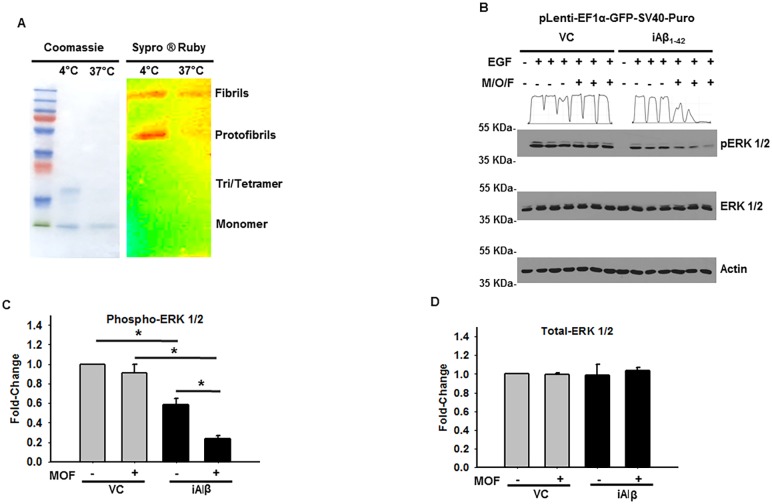
Differential influence of eAβ and iAβ on MAPK activity.(A) Confirmation of successful generation of extracellular monomeric, oligomer and fibrillar quaternary organization. Coomassie brilliant blue stained, 15% SDS PAGE gel, showing the varying eAβ quaternary organization states at 4°C and 37°C oligomerization protocols. Preferential staining of lower order eAβ organization observed using coomassie staining at 4°C. Sypro ® Ruby stained, 15% SDS PAGE gel, of eAβ1–42 revealing the higher order quaternary organization states. (B) Immunoblot of the phospho-ERK 1/2 and total-ERK 1/2 in VC or iAβ transduced HEK293 cells following 24 h pretreatment with monomeric/oligomeric/fibrillary (M/O/F) eAβ and subsequent EGF stimulation. No differences in EGF responsiveness observed in the DMSO or M/O/F treated VC samples. Decreased ERK 1/2 phosphorylation seen in iAβ transduced cells treated with M/O/F relative iAβ transduced cells treated with DMSO alone. Beta-actin employed as loading control. (C) Plot of the relative densitometry analysis of phospho-ERK 1/2 intensity in VC or iAβ after treatment with DMSO or M/O/F of biological replicates with data shown as mean ± SE (n = 3) and statistical significance. (D) Plot of total-ERK levels demonstrate intensity remains unchanged in all treatment categories. Complete pairwise analysis shown in Table 1.